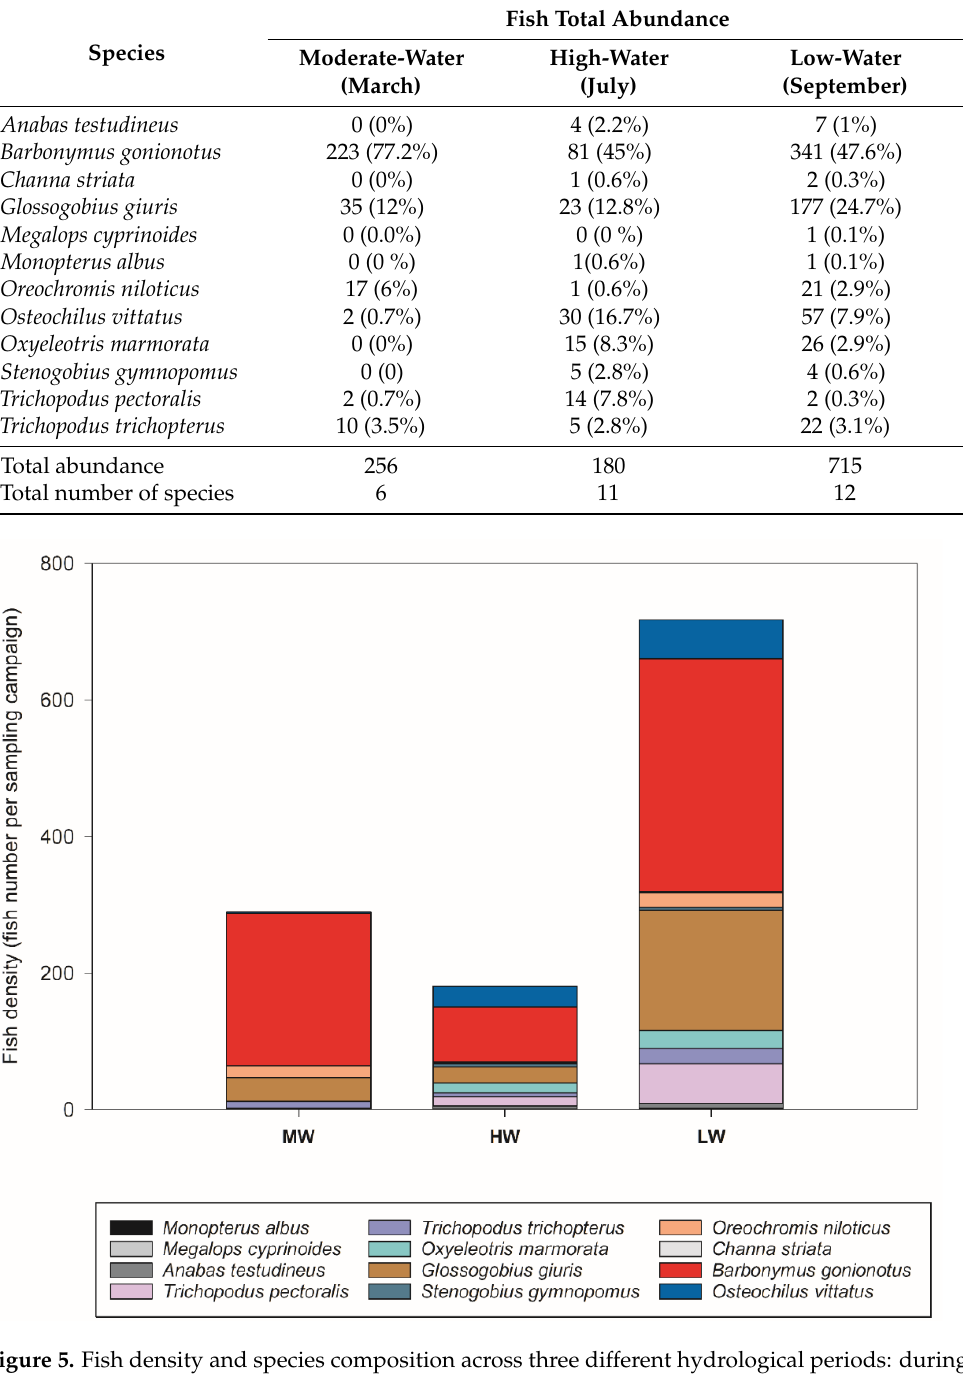
Table 5. Fish mean total abundance in three different hydrological periods. Relative abundance of each species is given in parentheses.